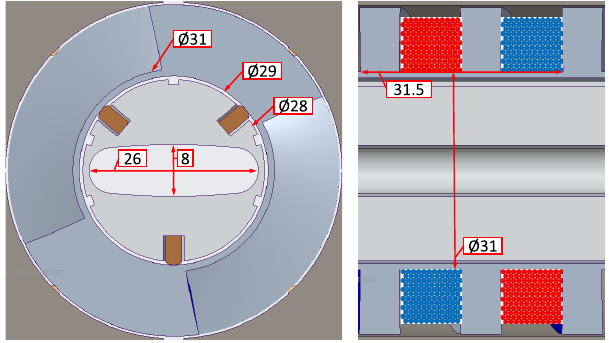
FIG. 2. Cross sections of the HSCU magnet and beam chamber, all dimensions in mm.